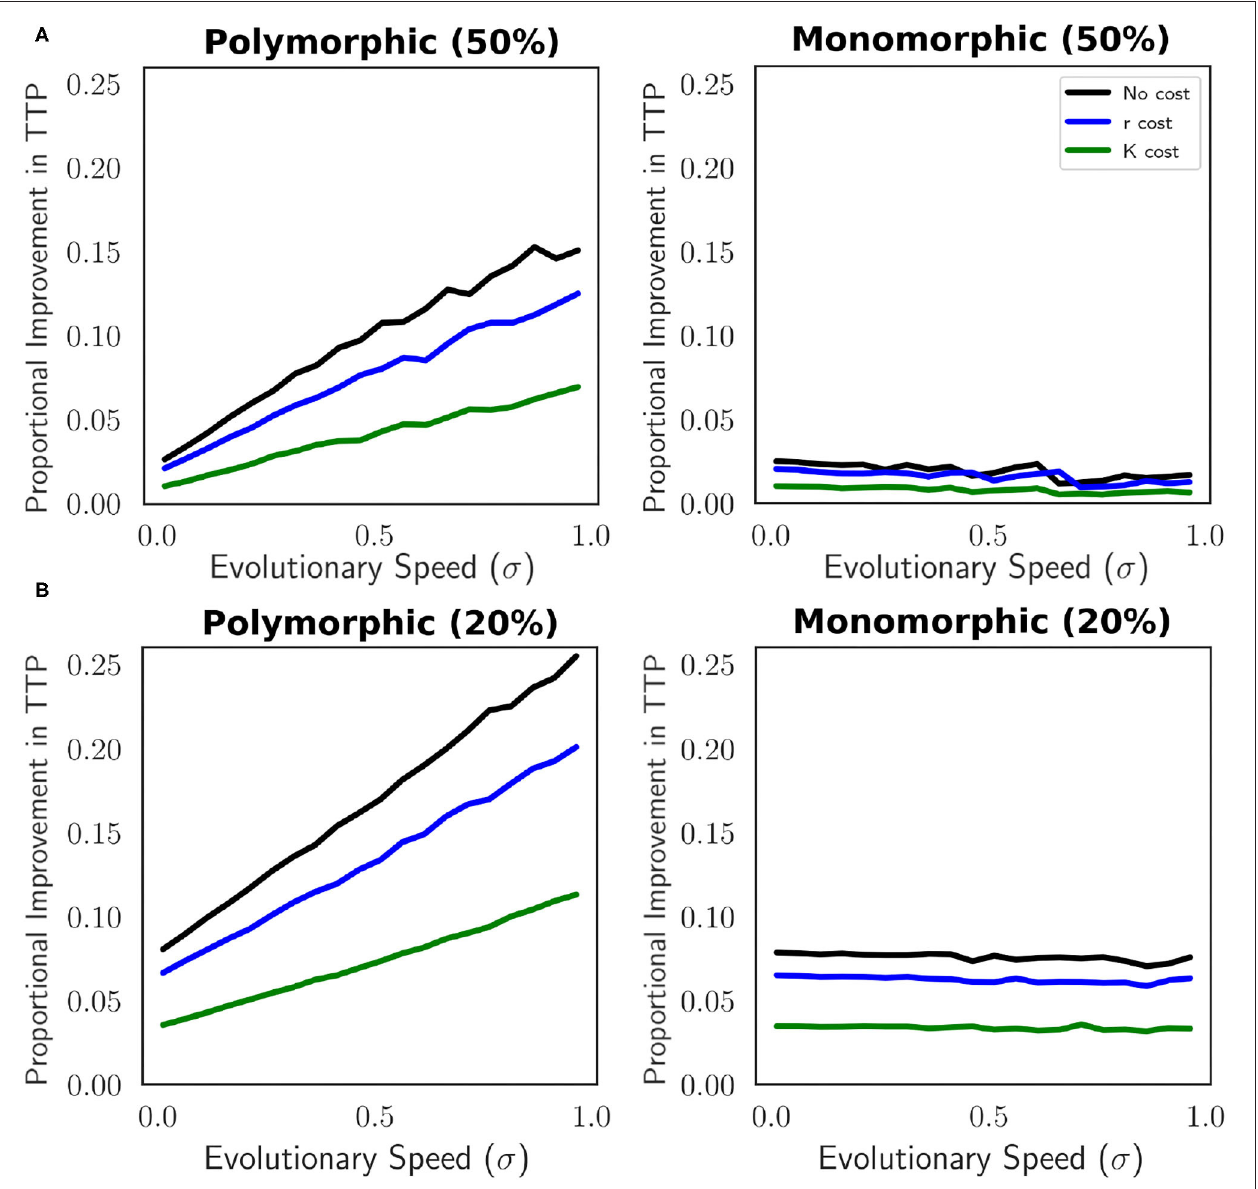
FIGURE 7 | Comparison of proportional improvement in TTP as a function of evolutionary speed for a monomorphic and polymorphic tumor cell population. Three models of resistance are compared: no cost of resistance, cost of resistance expressed in r , and cost of resistance expressed in K . (A) Therapy is withdrawn once the population density ≤ 3,000 (50% of the initial population size) and re-administered once the population ≥ 6,000 (initial population size). (B) The threshold to remove therapy is reduced thus from 50% to 20%. Therapy is withdrawn once the population density ≤ 4,800 (20% decrease from initial population size) and re-administered once the population ≥ 6,000 (initial population size). The superiority of AT when the population is monomorphic is minimal and as evolutionary speed increases the relative benefit of AT declines. A polymorphic population of cells allows for a greater effectiveness of AT. In this case, when the speed of evolution is quick AT provides a greater proportional benefit. Withdrawing therapy at 20% opposed to 50% improves the proportional increase in the effectiveness of AT. The parameters used in this figure are: m = 1, K max = 10,000, r max = 0.45, k = 2, b = 10, d = 0.01, g =